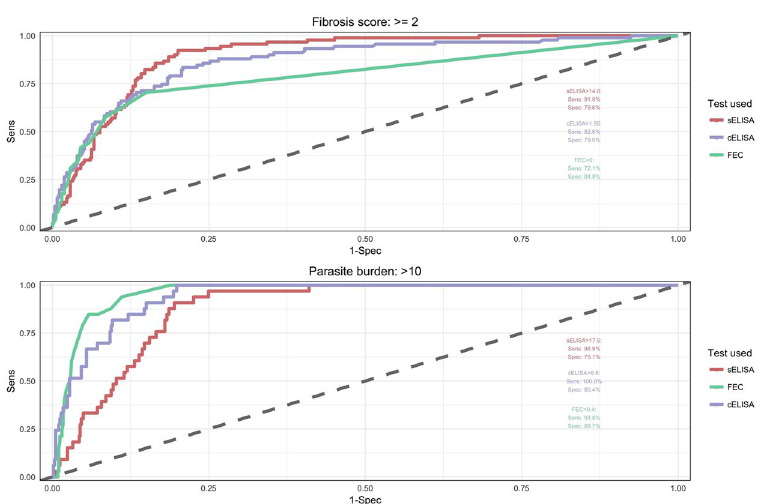
Figure 9. ROC curves. ROC curves were used to evaluate the ability of each diagnostic test to distinguish between 1) animals with a fibrosis score of 2 or more vs. a fibrosis score of 0 or 1 (top plot), and 2) animals with a parasite burden of more than 10 vs. animals with 10 or fewer flukes (bottom plot). Each plot provides suggested cut-off values for each tests along with the sensitivity and specificity estimates of each test at that cut- off